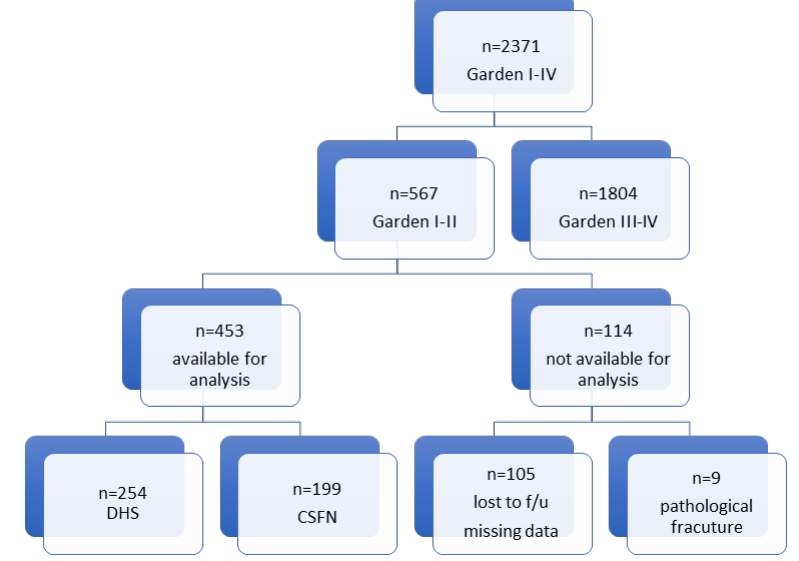
Figure 3. Flowchart showing detailed reasons for exclusion of patients sustaining a medial femoral neck fracture.